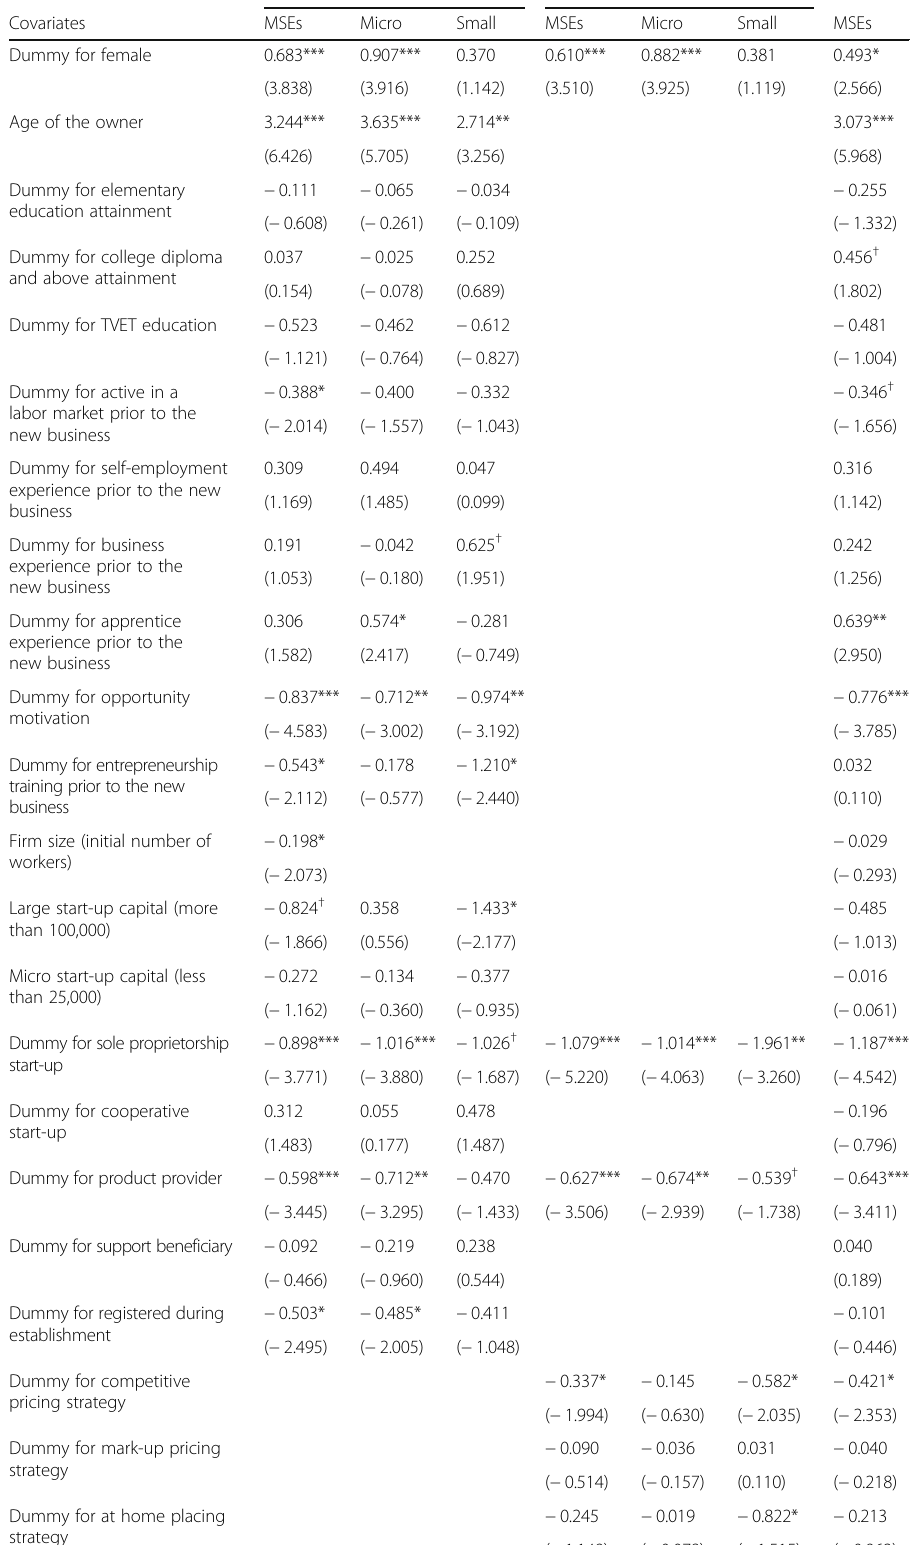
Table 3 Partial likelihood estimates for the Cox proportional hazard